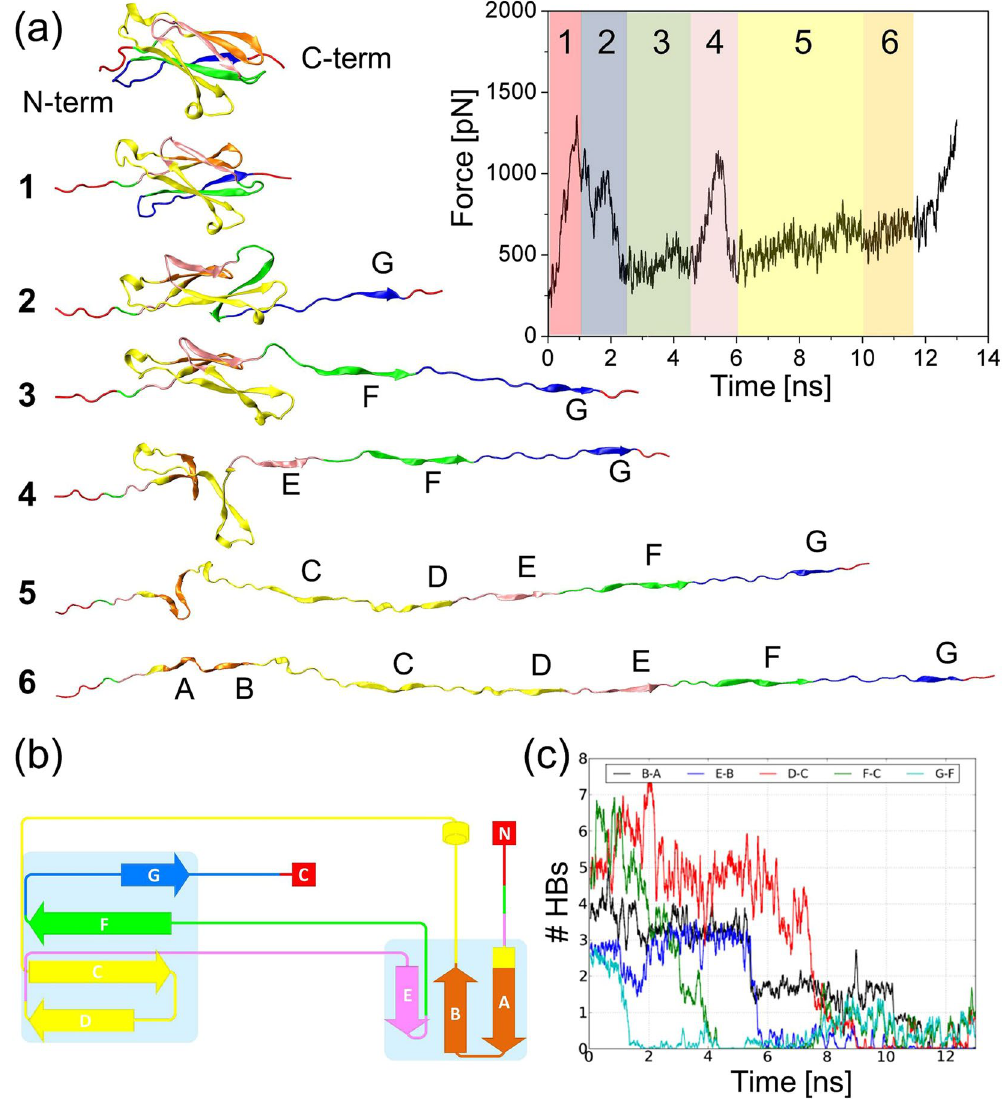
Figure 6. Gradual unfolding of the FnIII 3 domain of CNTN4. Snapshots from simulations at various time points of the mechanical unfolding are shown. The accompanying time evolution of force is shown on the upper right. ( b ) Schematic structure of FnIII 3 domain of CNTN4. Colors denote the sequence of unfolding events. ( c ) Change in the number hydrogen bonds traced during the course of stress-induced unfolding for 5 pairs of β -strands making hydrogen bonds in the folded